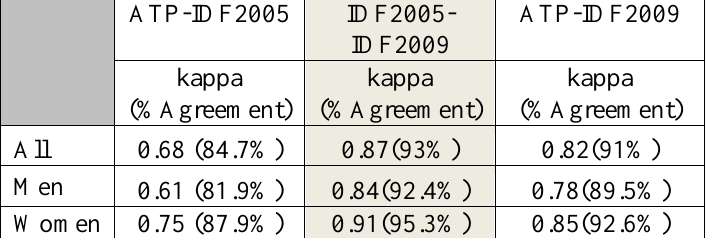
The agreement between the clinical definitions in identifying participants with MetS was between 84.7%– 93%. The highest levels of agreement were observed between IDF2005 and R IDF 2005 [k (% agreement) = 0.87(93%)] and the lowest levels of agreement were observed between M ATP III